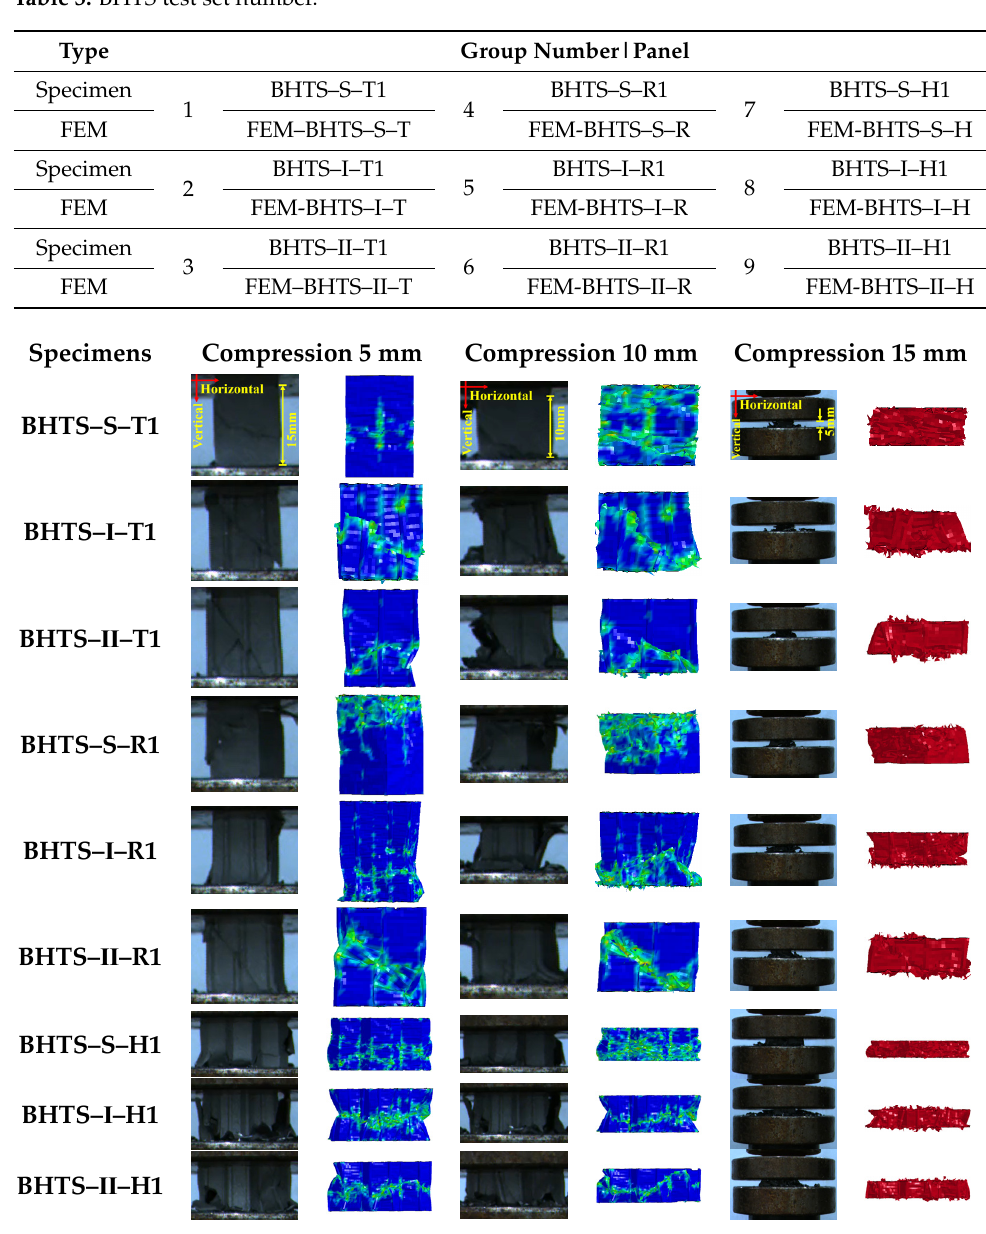
Figure 8. The crushing process of BHTS specimens under quasi ‐ static uniaxial compression loading. Table 3. BHTS test set number.